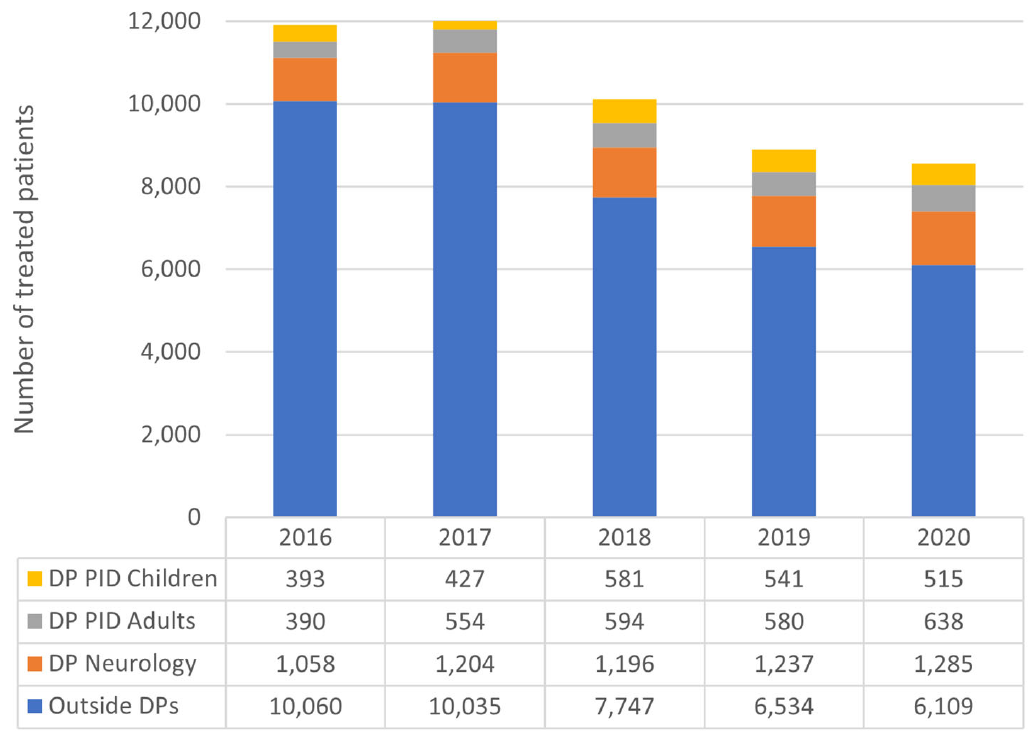
Figure 3. The number of patients treated annually with immunoglobulins, divided into drug programs and other indications. DP: drug program. PID: primary immunodeficiency. DPs: drug pro- grams.